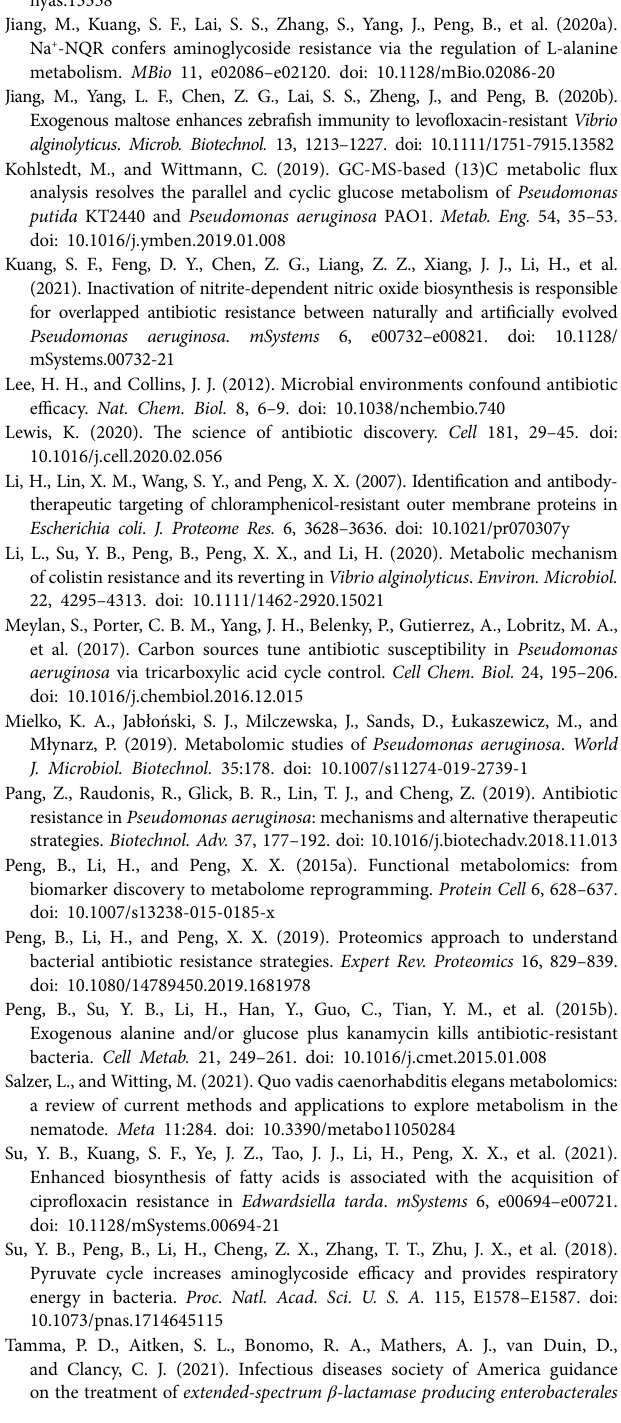
Supplementary Figure 1 | Pathway enrichment. (A) Pathway enrichment of differential metabolites in PA-R8 SCF and PA-R16 SCF based on controls PA-S8 and PA-S16, respectively. Significant enriched pathways are selected to plot. Value of p < 0.05. (B) Integrative analysis of metabolites in significantly enriched pathways. Yellow color and blue color indicate increased and decreased metabolites,